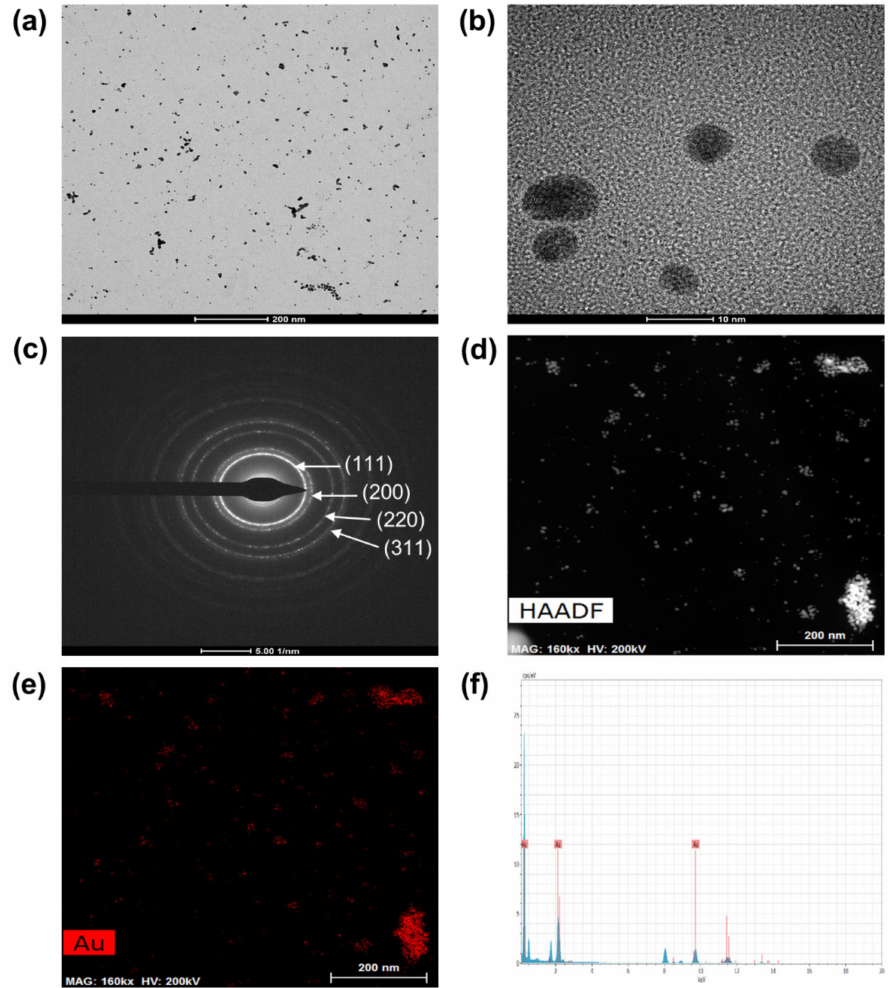
Figure 4. HR-TEM images ( a , b ), SAED pattern ( c ), HAADF images ( d , e ) and EDX spectra ( f ) of SS-AuNPs. 58 k ( a ), 630 k ( b ), 115 k ( d , e ).